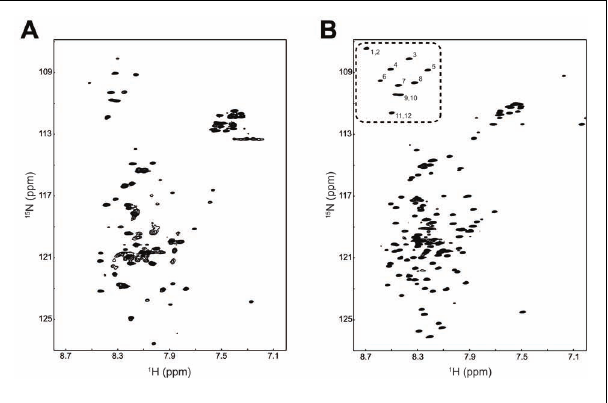
FIGURE 6 | Demonstrating the feasibility of solving theTM4-Cx45CT structure. 15 N-HSQC of theTM4-Cx45CT in 20 mM MES, 1 mM DTT, 1 mM EDTA, and 8% 1-palmitoyl-2-hydroxy-sn-glycero-3-[phospho-RAC- (1-glycerol)] detergent micelles (A) alone or (B) in the presence of 30% deuterated acetonitrile. Highlighted are the 12 Gly residues in the TM4-Cx45CT (dotted rectangle, numbered).